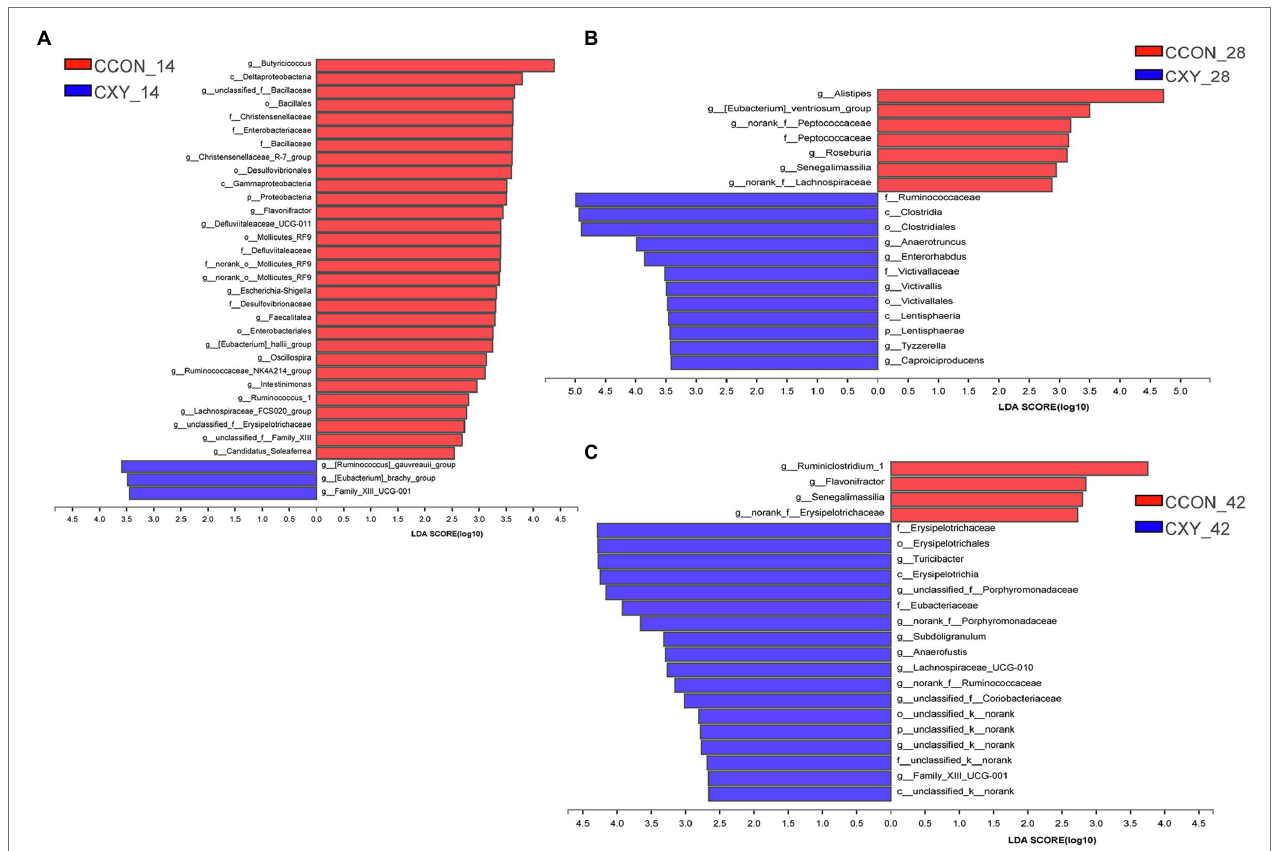
FIGURE 7 | The LEfSe analysis for cecal bacteria communities from phylum to genus level in CCON and CXY groups. Different bacterial communities from phylum to genus level between CCON (denoted by red bars) and CXY (denoted by blue bars) groups on d 14 (A) , d 28 (B) , and d 42 (C) . Corn-soybean basal diet (CCON); corn-soybean basal diet with 4,000 U/kg xylanase